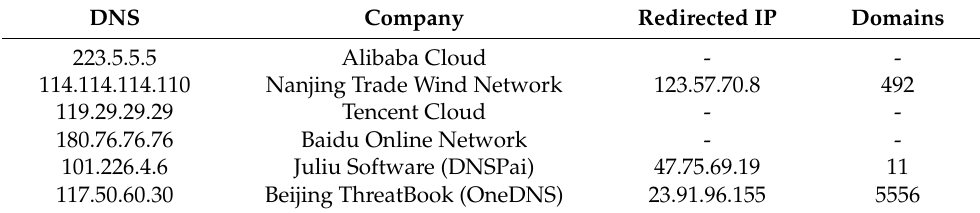
Table 8. Overview of recursive DNS servers and the results of handling of abusive domains.